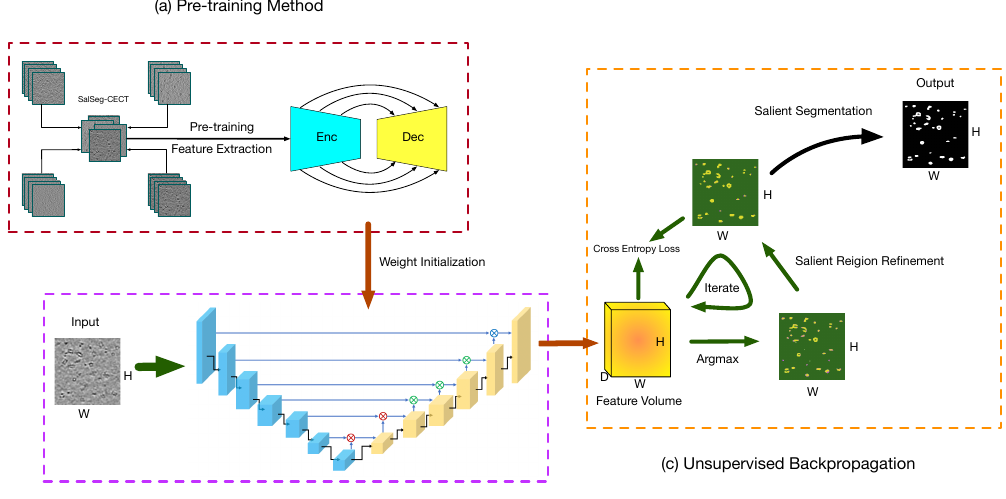
Figure 2. The overview framework of our proposed method. The processing pipeline consists of three main steps: ( a ) pre-training on the SalSeg-CECT data set; ( b ) prediction using the U-SalNet model; ( c ) unsupervised attentional backpropagation iterating on single images. The Enc and Dec stand for the encoder and decoder. The (cid:78) , (cid:78) , and (cid:78) denote the global attention mechanism, local attention mechanism and convolutional decoding,